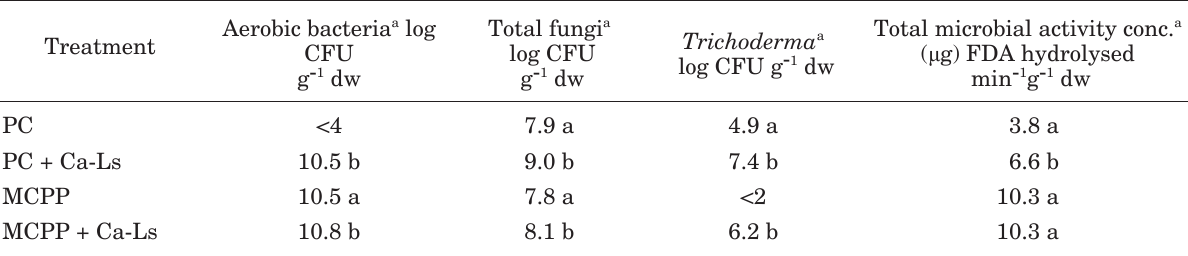
Table 1. Populations of aerobic bacteria, total fungi, Trichoderma species in the organic substrates PC (88% peat + 12% coconut fibres) and MCPP (25% municipal compost + 15% peat + 60% pumice) 3 weeks after amendment with 1.5% (v/v) calcium lignosulphonate (Ca-Ls). Each microbial characterisation was determined in three samples of each treatment. Microbial enumeration was determined by plate count technique.